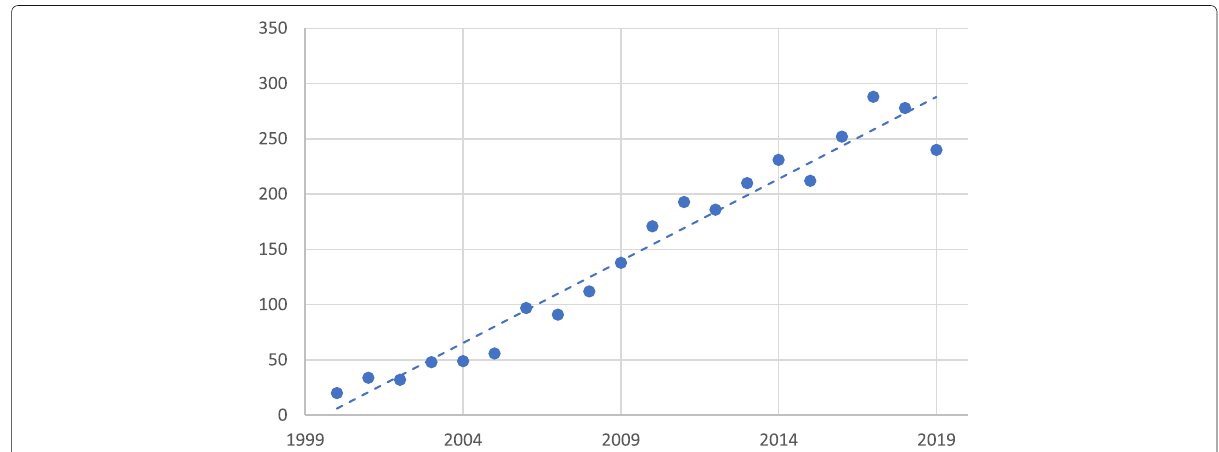
Fig. 1 Number of articles and papers mentioning the term ‘socially responsible investment’ per year (source: IDEAS-REPEC database, 2000-2019)